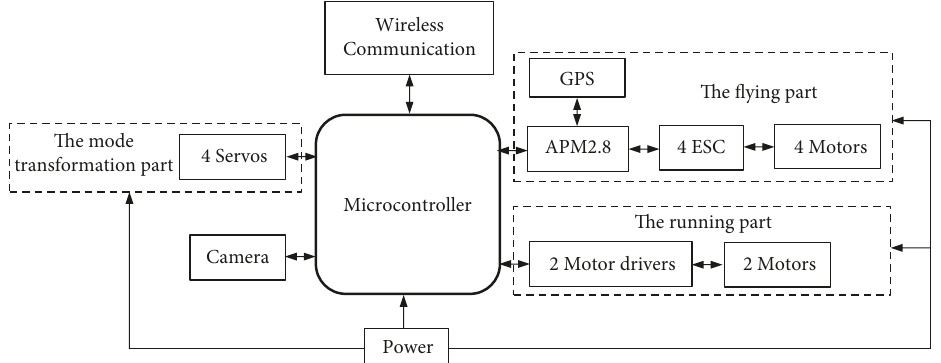
Figure 3: The control system of the transformable land/air